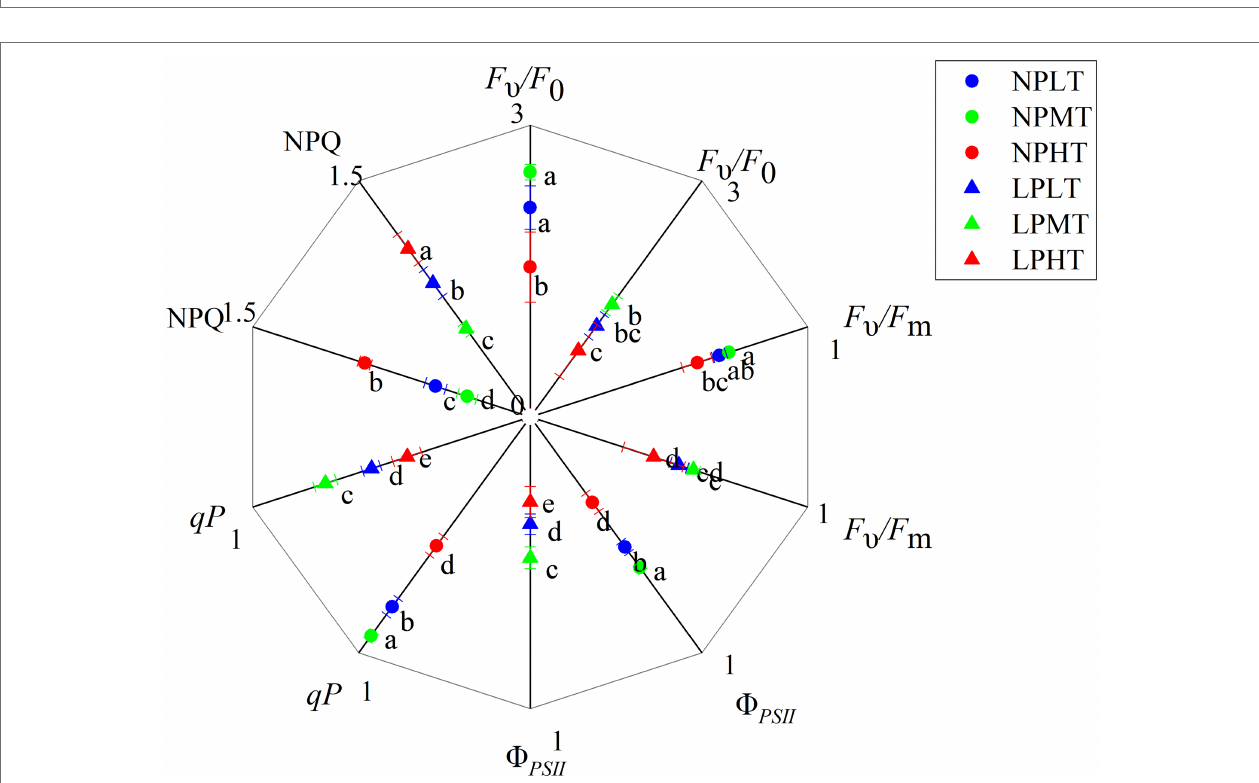
FIGURE 5 | Effect of root zone temperature and phosphorus content on fluorescent characteristics. NT: 24 ° C, MT: 30 ° C, and HT: 36 ° C (root zone temperature); LP: 1.25 μ m and NP: 250 μ m (phosphorus content). Notations above bars of a, b, c, d, and e indicate homogeneous groups ( α = 0.05).